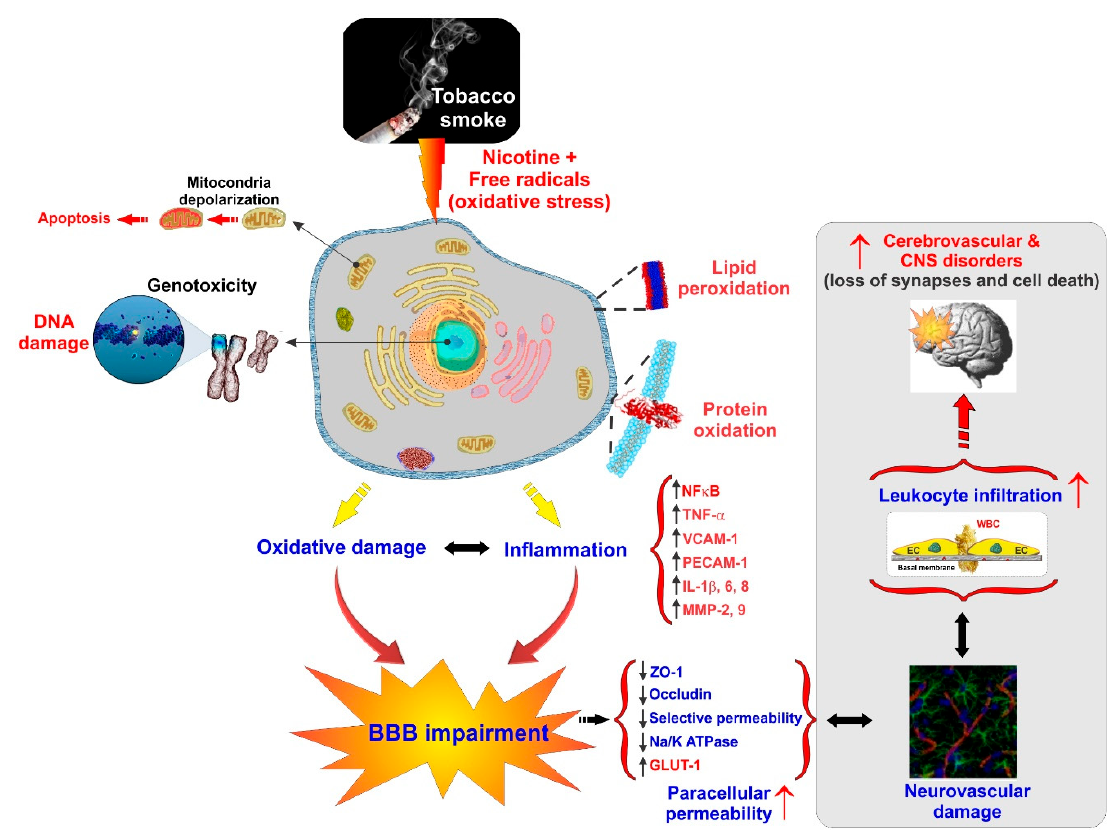
Figure 3. Schematic illustration of the impact of smoking on BBB impairment and the onset of cerebrovascular and CNS disorders. Note that an “up arrow” indicates upregulation while a “down arrow” indicates downregulation